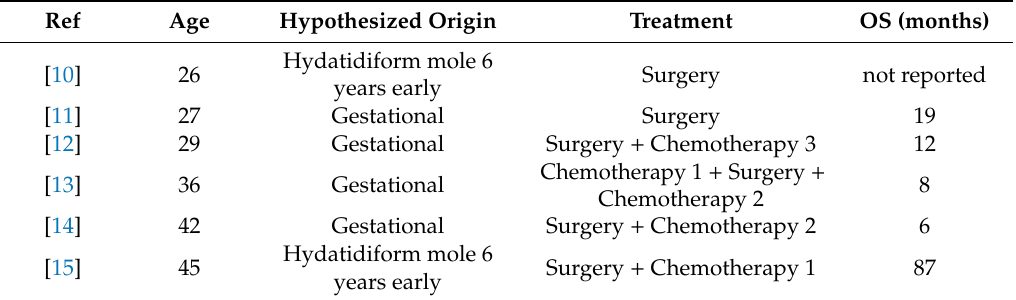
Table 2. Literature review of single lung metastasis report from choriocarcinoma. All patients were female.